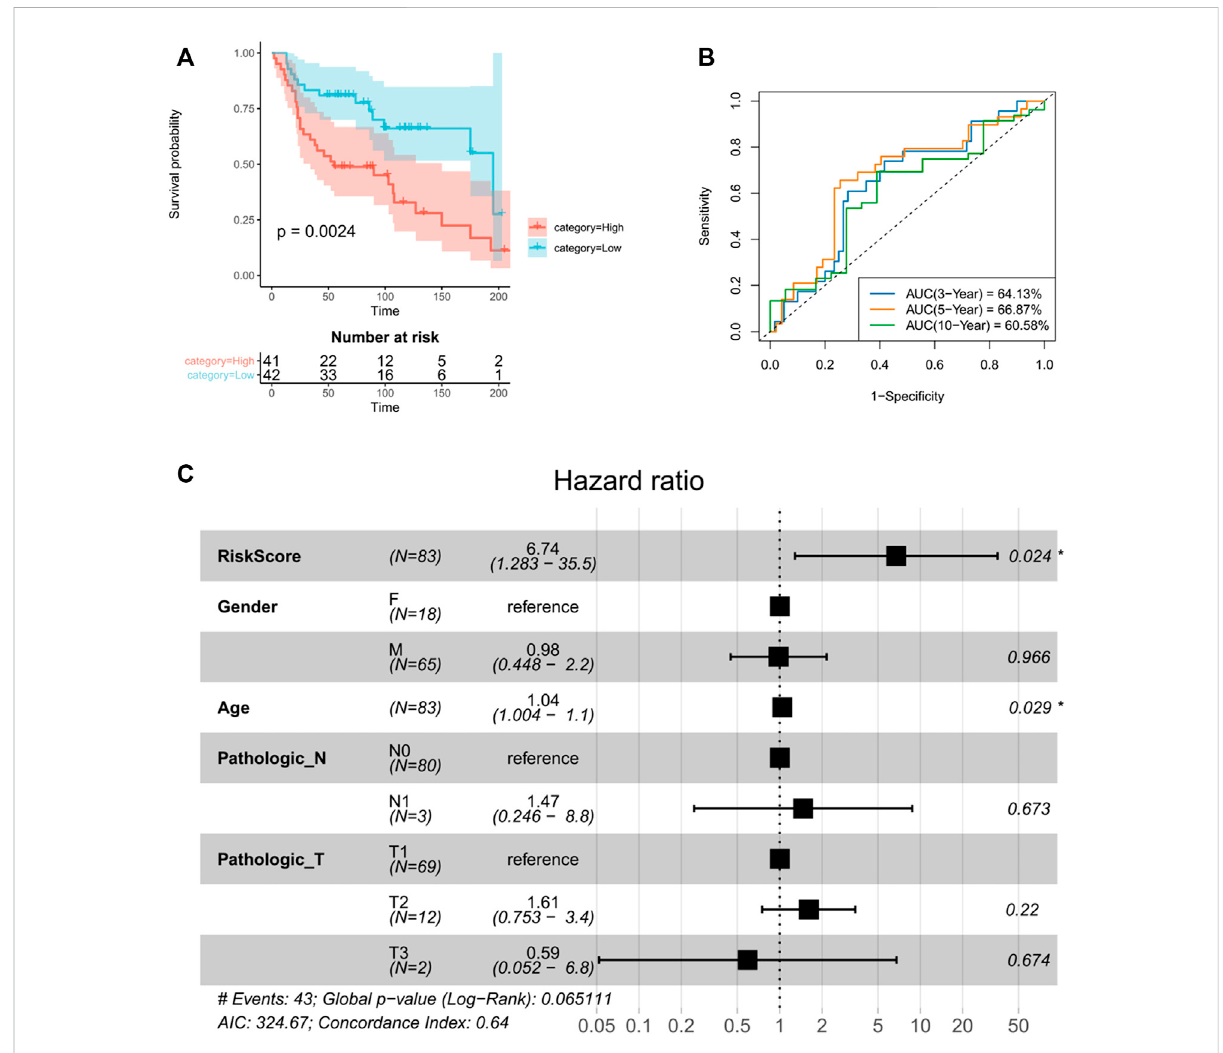
FIGURE 8 The TANlncSig was independently validated in the GSE30219 dataset (A) . Kaplan – Meier survival curves of OS were plotted between high- and low-riskgroupsstrati fi edbytheTANlncSig. (B) TimeROCcurveofluadpatientstheGSE30219dataset. (C) VisualizationoftheHRsfromamultivariate Cox analysis of the TANlncSig and clinicopathological factors in